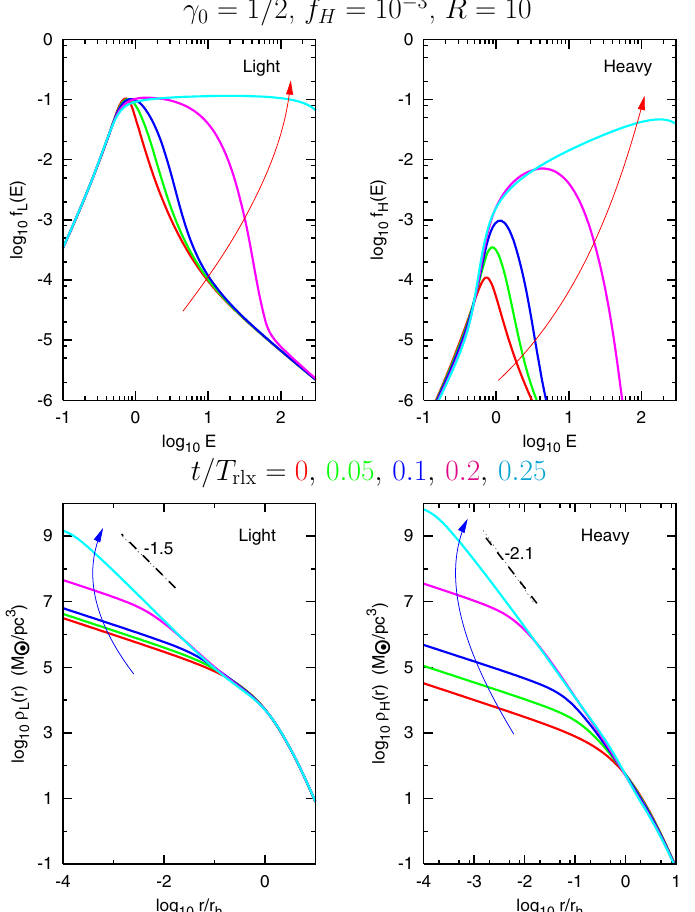
Fig. 49 Upper panels: Evolution of the phase-space f ( E ) density, defined as in Binney and Tremaine (1987) Lower panel: Same for the spatial density ρ( r ) , from the simulations of Preto and Amaro-Seoane (2010)usingtheirFPcodewhichisisotropic,orbit-averagedmulti-massinenergyspace.Indifferentcolours we have different moments in the evolution of the system in units of the relaxation time. Image adapted from Fig. 3 of Preto and Amaro-Seoane (2010)